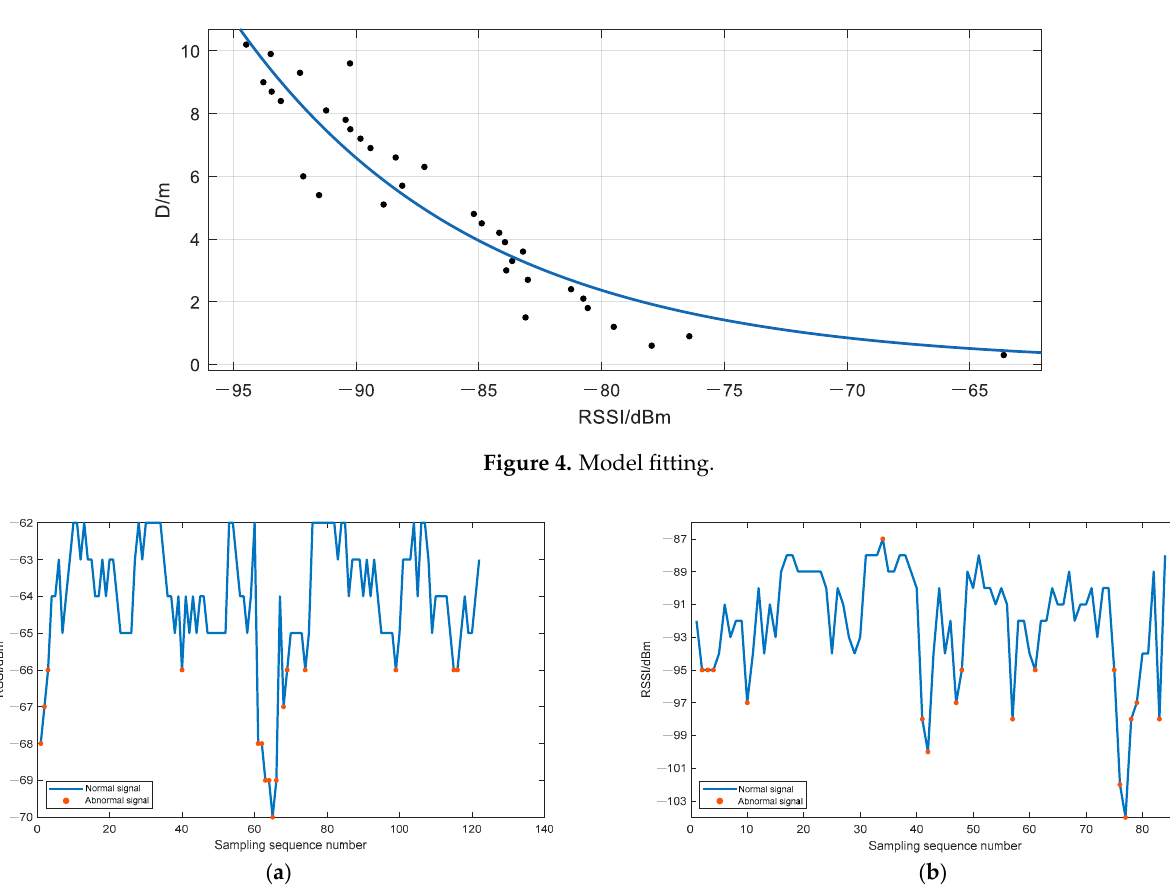
Figure 5. Anomaly detection: ( a ) Anomaly detection at 0.3 m. ( b ) Anomaly detection at 9 m